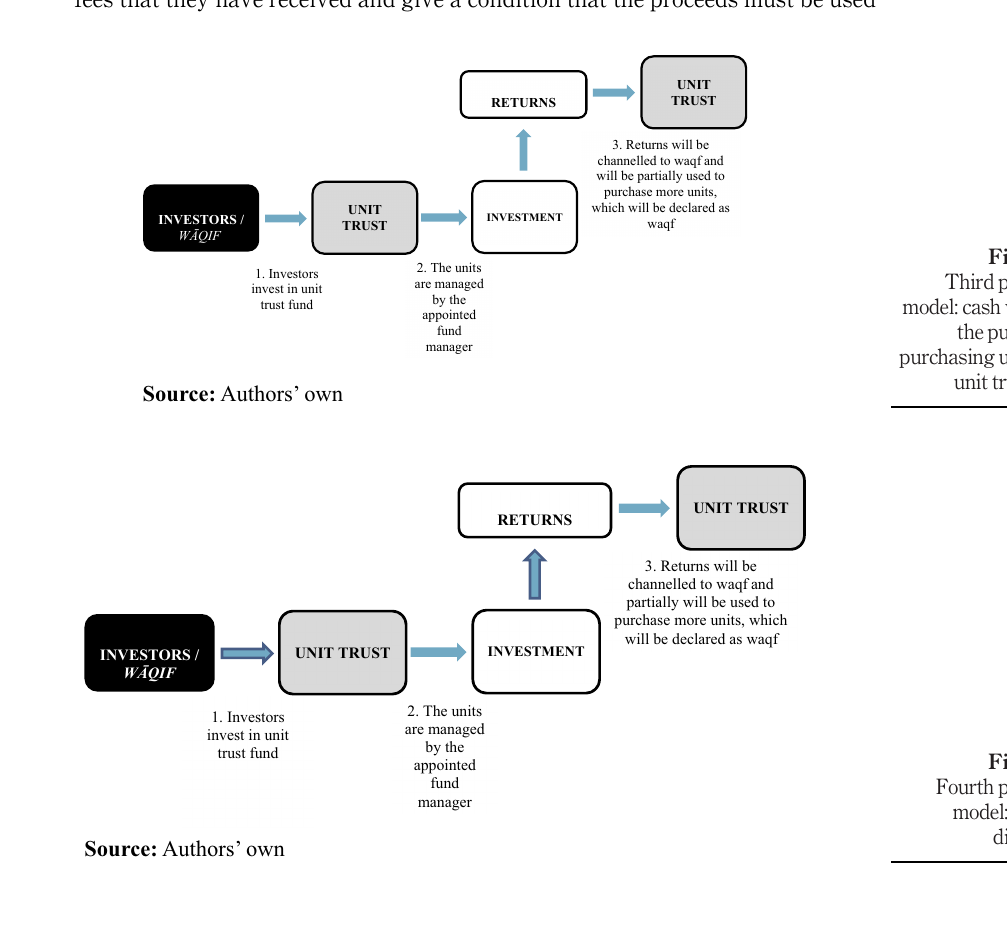
Figure 4. Third proposed model: cash waqf for the purpose of purchasing units in a unit trust